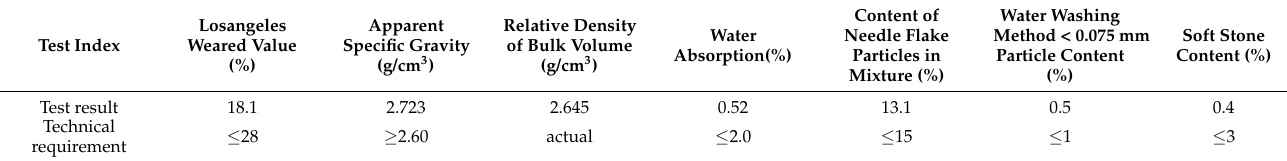
Table 4. Main technical indexes of 5~10 mm gravel.